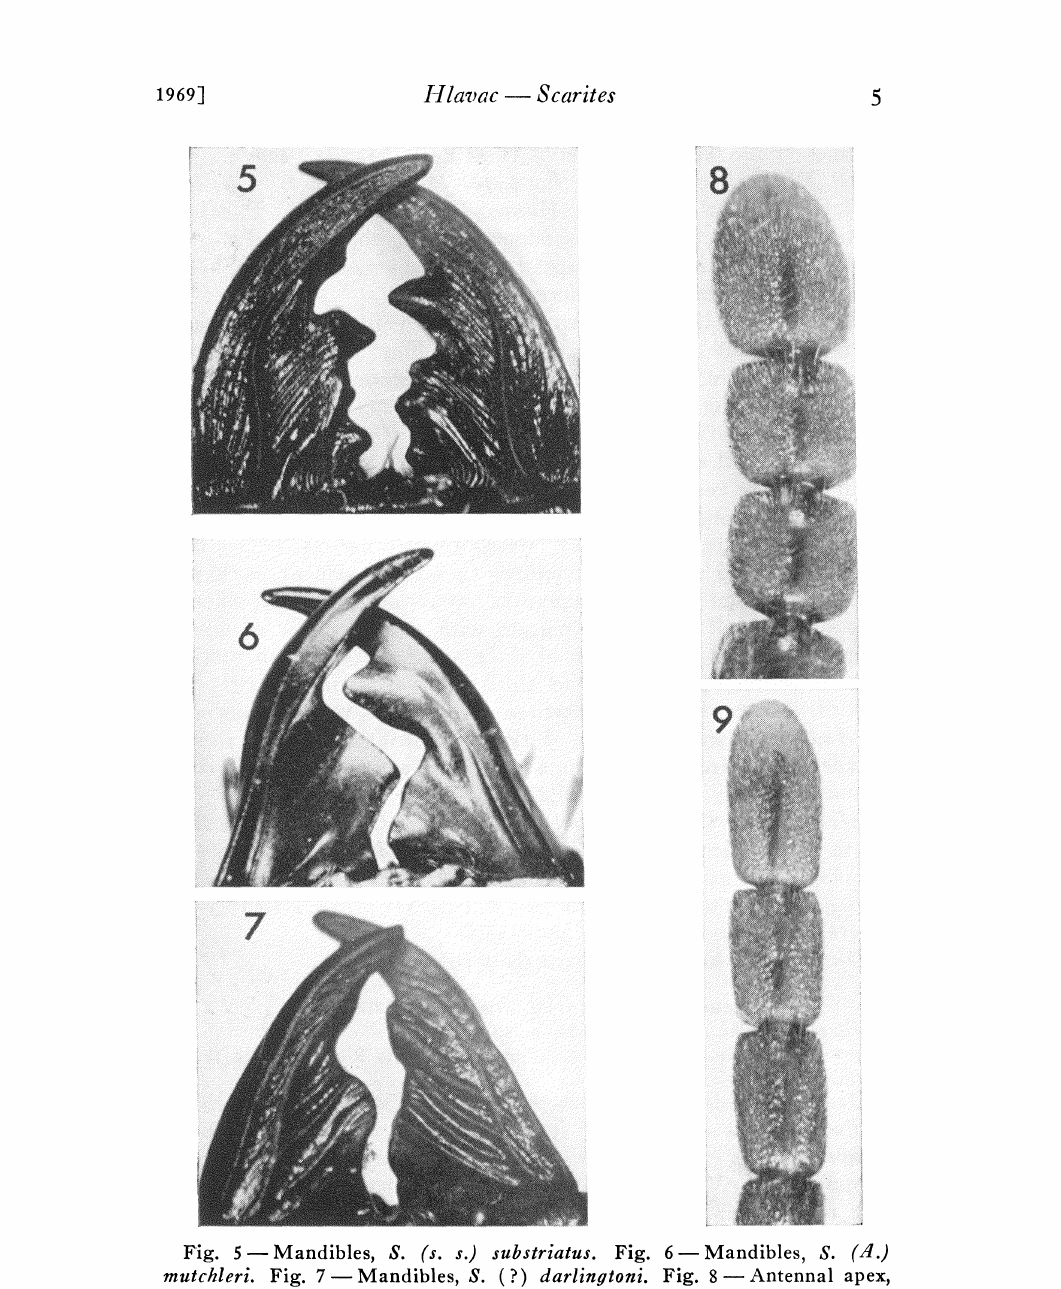
Fig. 5--Mandibles, S. (s. s.) substriatus. Fig. 6--Mandibles, S. (A.) mutchleri. Fig. 7 Mandibles, S. (?) darlingtoni. Fig. 8-- Antennal apex, (zl.) danforthi. Fig. 9--Antennal apex, 8. (A.)